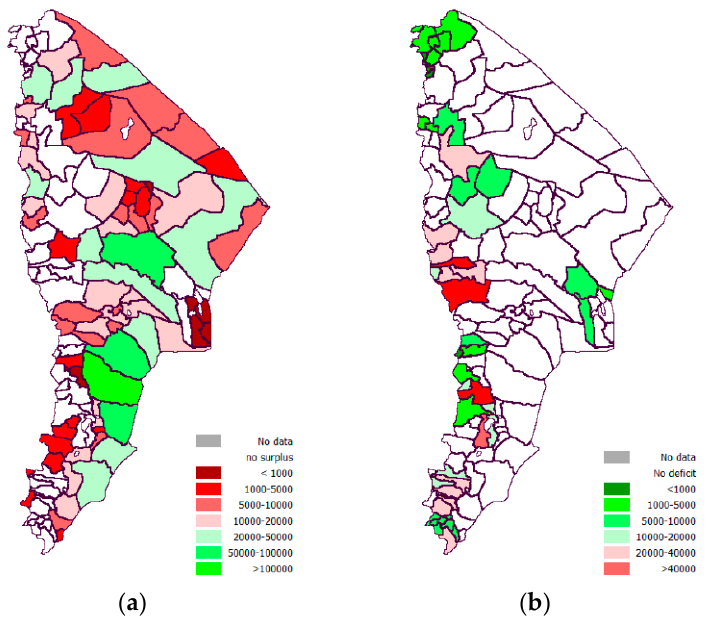
Figure 7. Surplus (panel a ) and deficit (panel b ) of annual fodder supply in case of no migration expressed in TLU (scale 1:6,500,000).